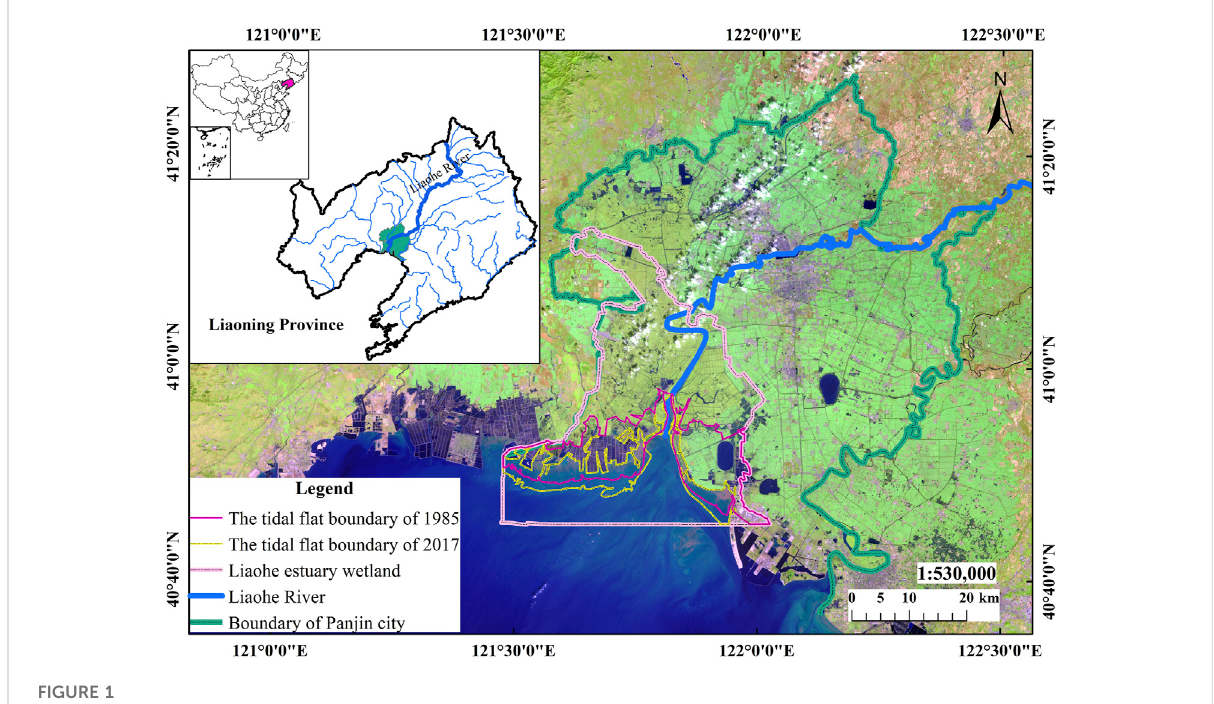
FIGURE 1 The location of the research